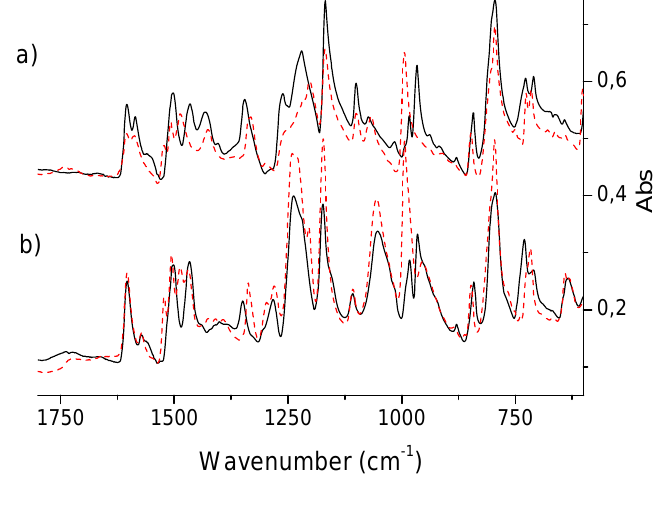
molecules. (b) Infrared absorption spectra of the HO-prop-TPPH TPPZn (dashed) molecules. N.b., the spectra of panel a) was added a constant (0.25)